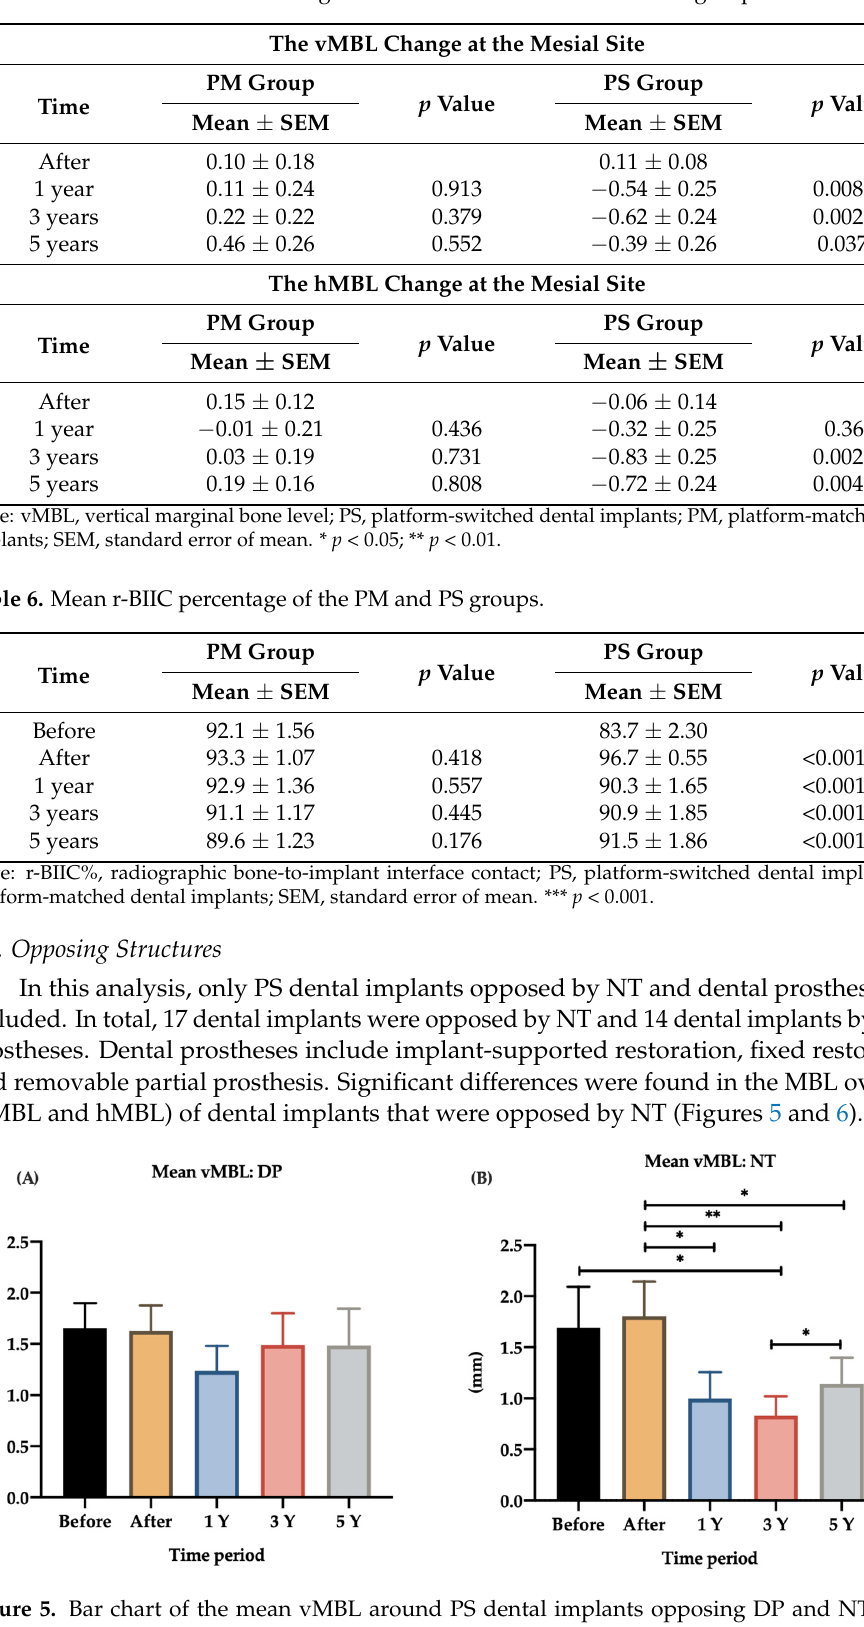
Table 5. The vMBL and hMBL change at the mesial site of the PM and PS groups.